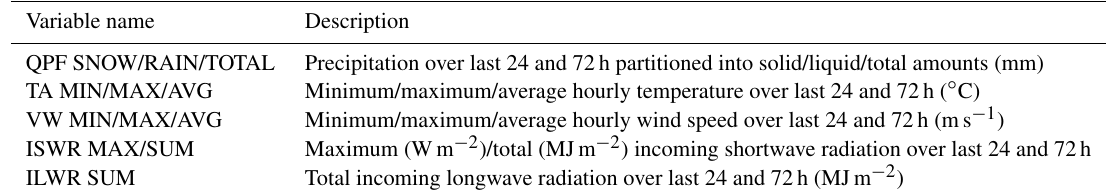
Table 2. Weather variables calculated from hourly data from the HRDPS numerical weather prediction